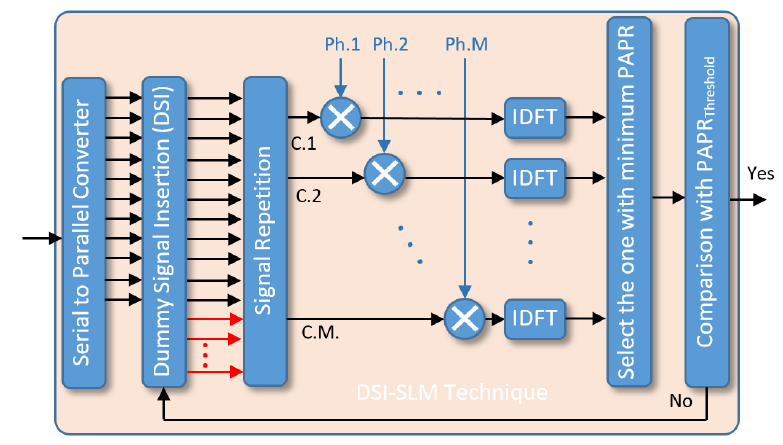
Figure 4. DSI-SLM PAPR reduction technique [20].